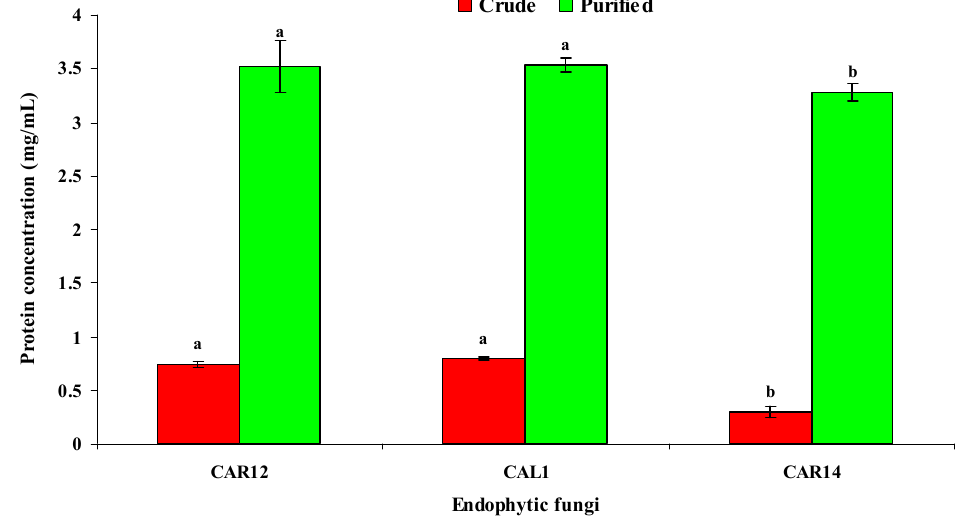
Figure 3. Total protein content in the crude and purified siderophore extract by Penicillium chrysogenum (CAL1). Treatment means annotated above by the same letter are not significantly different according to DMRT at p < 0.05 .